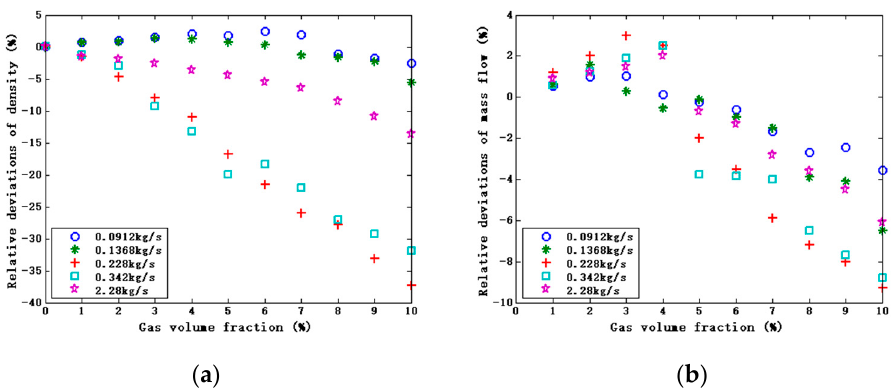
Figure 7. The original deviations of stratified flow relative to GVF before correction. ( a ) Relative deviations of density. ( b ) Relative deviations of mass flow.